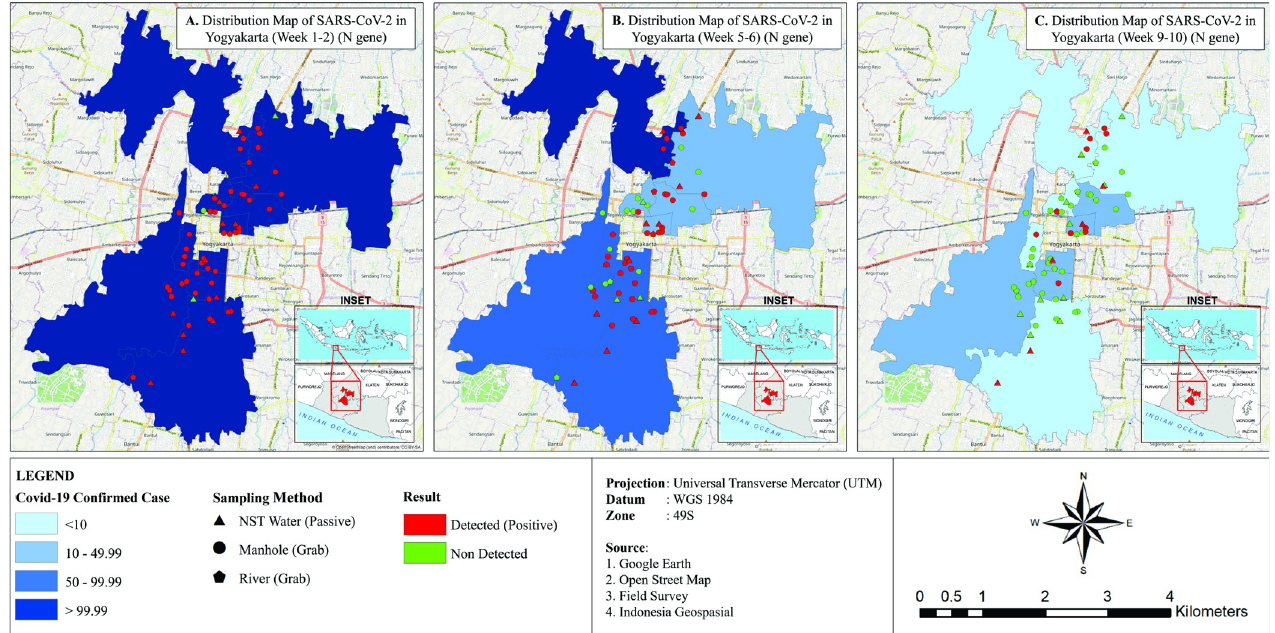
Fig 3. Distribution maps of SARS-CoV-2 in Special Region of Yogyakarta province, comparing detection targeting N gene to community confirmed cases. (A) In week 1–2 of the sample collection. (B) In week 5–6 of the sample collection. (C) In week 9–10 of the sample collection. Community COVID-19 confirmed cases were represented by blue color, the lighter the fewer cases. Detected cases in sampling locations were represented by red colored dots/triangles/ pentagons, while non-detected cases were represented by green colored dots/triangles/pentagons. With circles denoting manholes, pentagons denoting river and triangles denoting NST